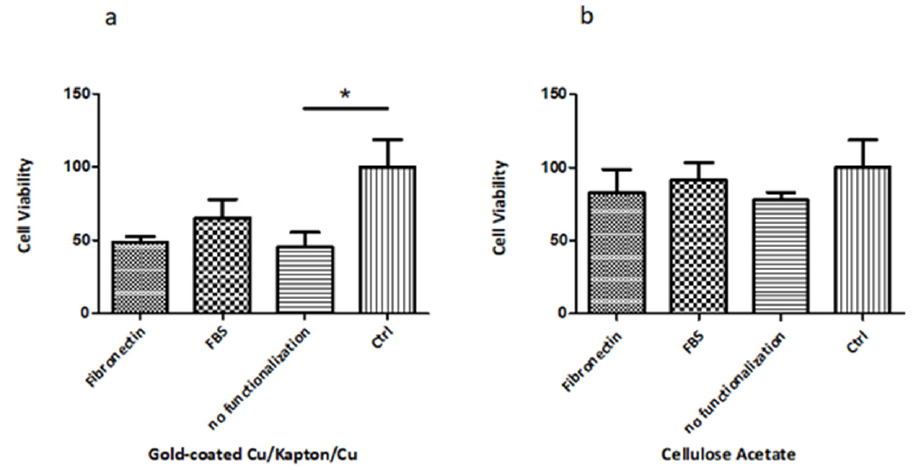
Figure 8. MTT Assay of PC-3 cells in culture medium conditioned with ( a ) CKC fragments coated with gold monolayer and ( b ) CA fragments functionalized with Fibronectin, FBS and no functionalization than control.